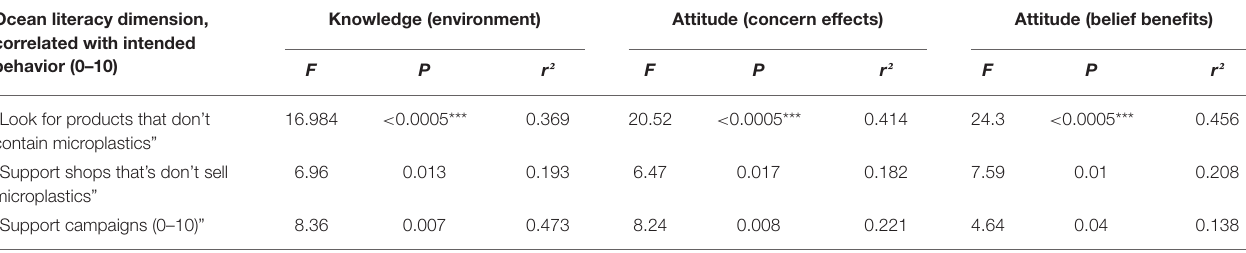
TABLE 8 | Regression calculations to assess extent to which predictors of behavior change (awareness, knowledge, attitude, self-efficacy and social norm) predict participants self-reported intended frequency of undertaking behaviors or actions to reduce the effects of microplastics on marine life. Ocean literacy dimension, correlated with intended behavior (0–10)